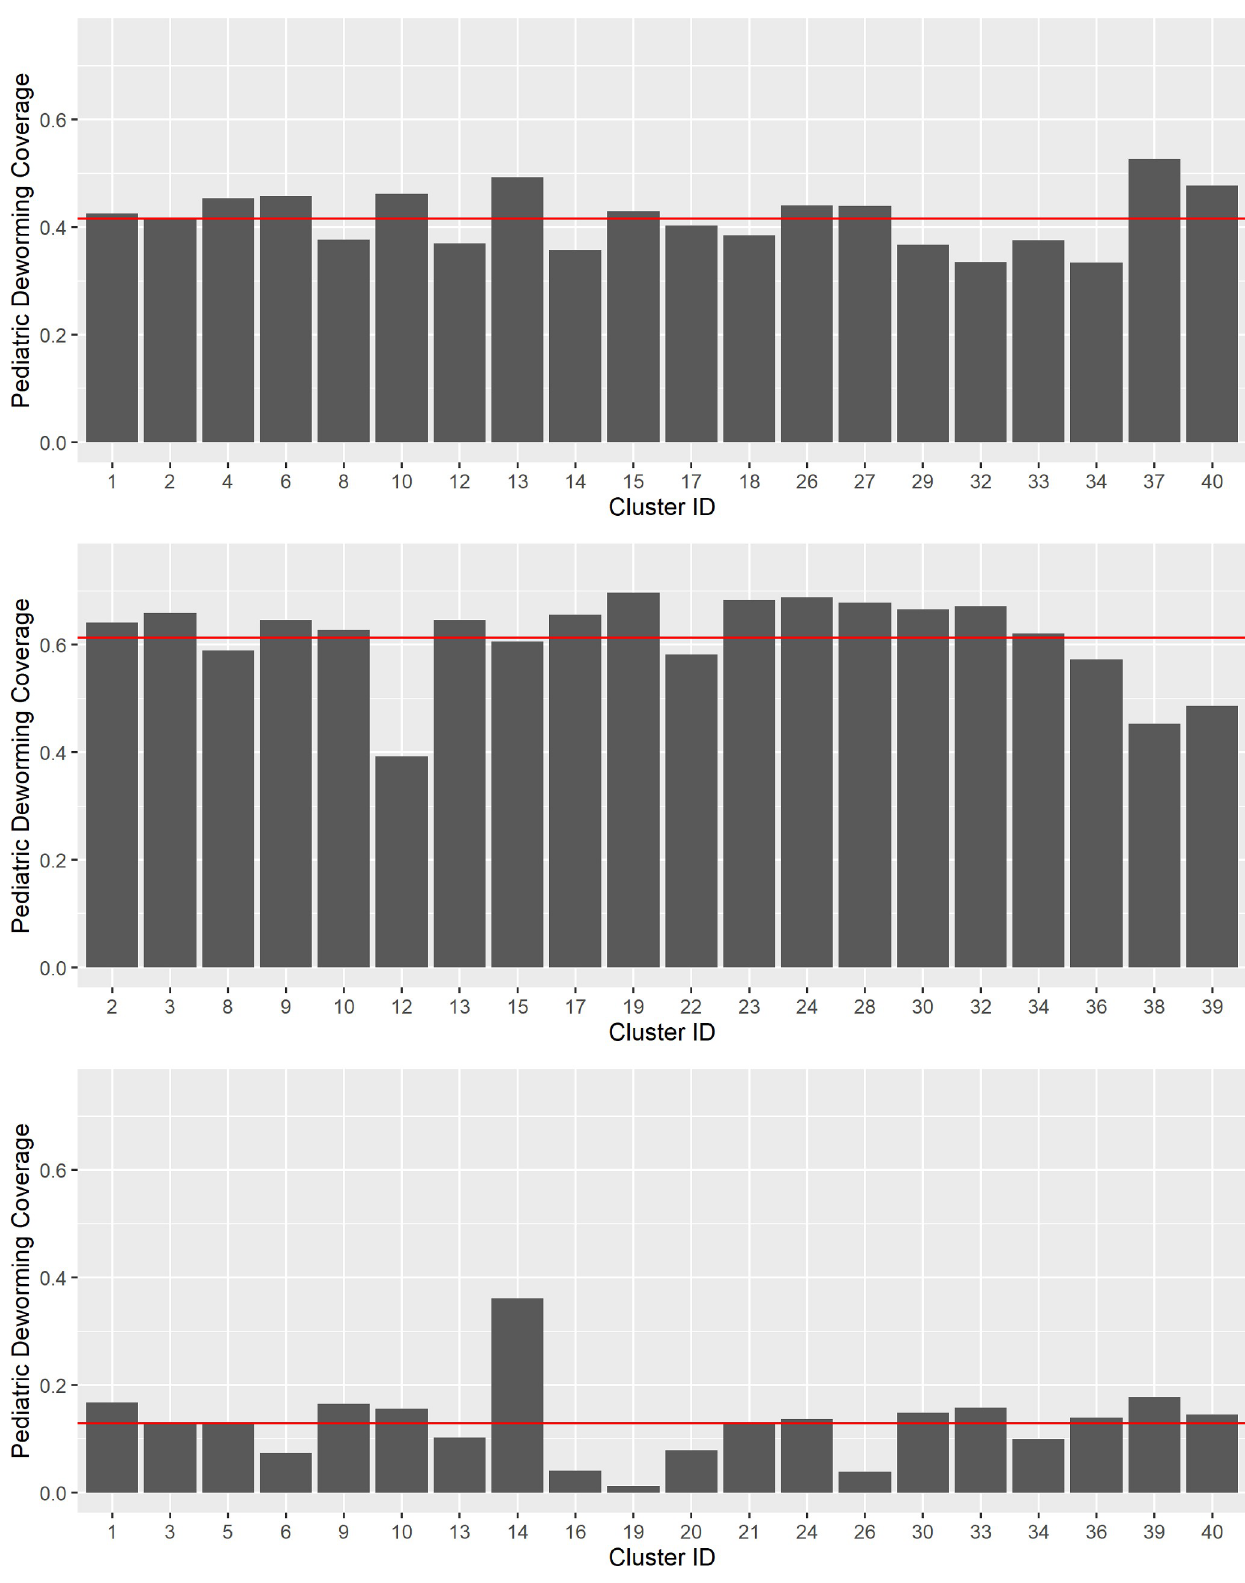
Fig 2. Individual-Level Reporting of SBD in Intervention Clusters, by Study Site. (A) Benin. (B) India. (C) Malawi. Mean SAC Deworming Coverage shown as a red slicer line. Y-Axis set to WHO target of 75% coverage for SAC and PSAC. https://doi.org/10.1371/journal.pntd.0010401.g002 PLOS NeglectedTropical Diseases | https://doi.org/10.1371/journal.pntd.0010401 April 10,